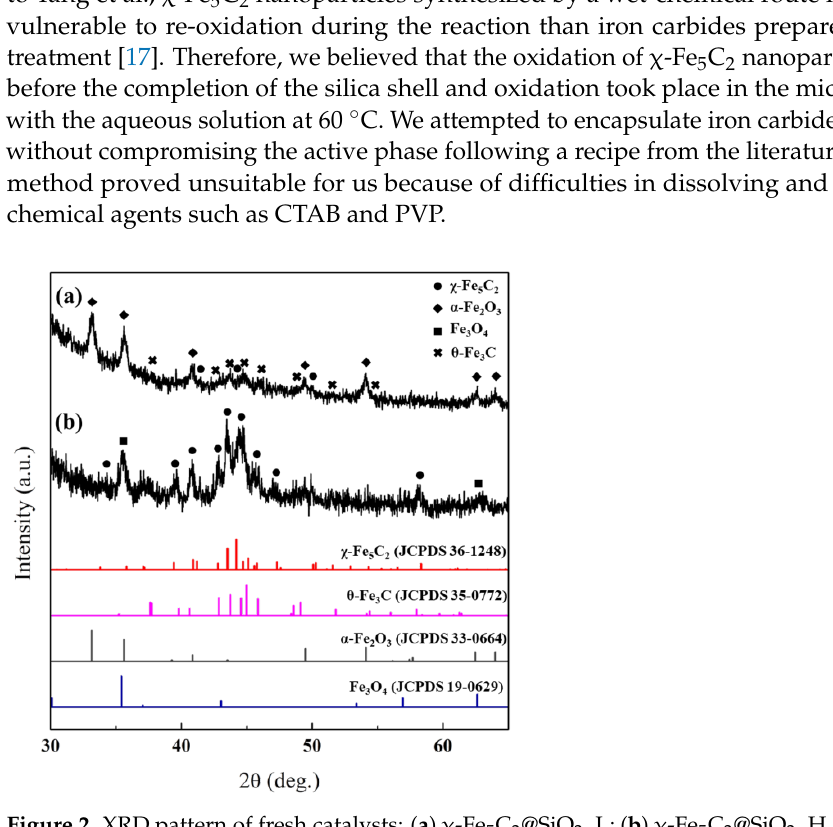
Figure 2. XRD pattern of fresh catalysts: ( a ) χ -Fe 5 C 2 @SiO 2 _L; ( b ) χ -Fe 5 C 2 @SiO 2 _H. In order to suppress the phase change, the contact time with the aqueous solution mixture was decreased as much as possible when the χ -Fe 5 C 2 @SiO 2 _H catalyst was encap- sulated with a silica shell. As a result, the XRD spectrum of Fe 5 C 2 @SiO 2 _H exhibited the χ -Fe 5 C 2 (JCPDS No. 36-1248) phase and the Fe 3 O 4 (JCPDS No. 19-0629) phase, which was a less oxidized phase than the α -Fe 2 O 3 phase of the χ -Fe 5 C 2 @SiO 2 _L catalyst as mentioned above. The number of transformed phases and the degree of oxidation were found to be significantly reduced.